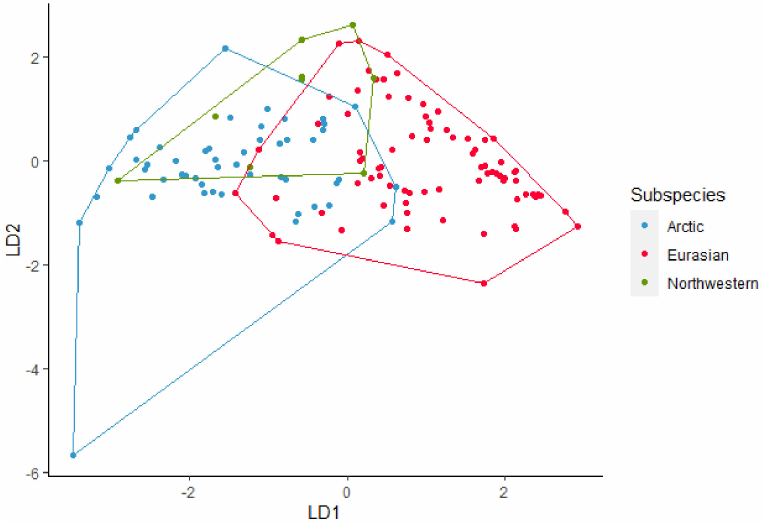
Figure 2. Linear discriminant (LD) analysis plot for identification of the subspecies Arctic, Eurasian, and Northwestern wolves with a 78% correct classification. Table 4. Pairwise post-hoc Hotelling test for Subspecies with F-values, p -values, and number of degrees of freedom (DF). Symbol # indicates significant p -values after sequential Bonferroni. F p